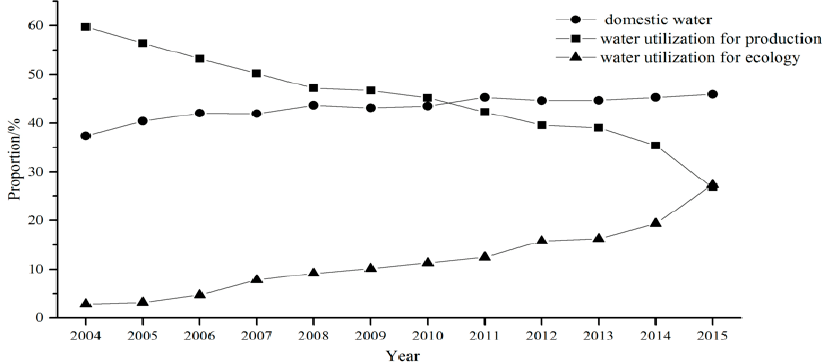
Figure 1. The water utilization proportion for life, production and ecology from 2004 to 2015.